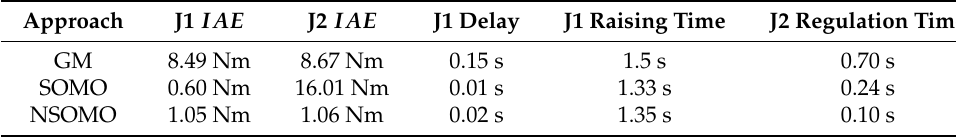
Table 2. Comparison of three observers’ specific response performance and IAE.